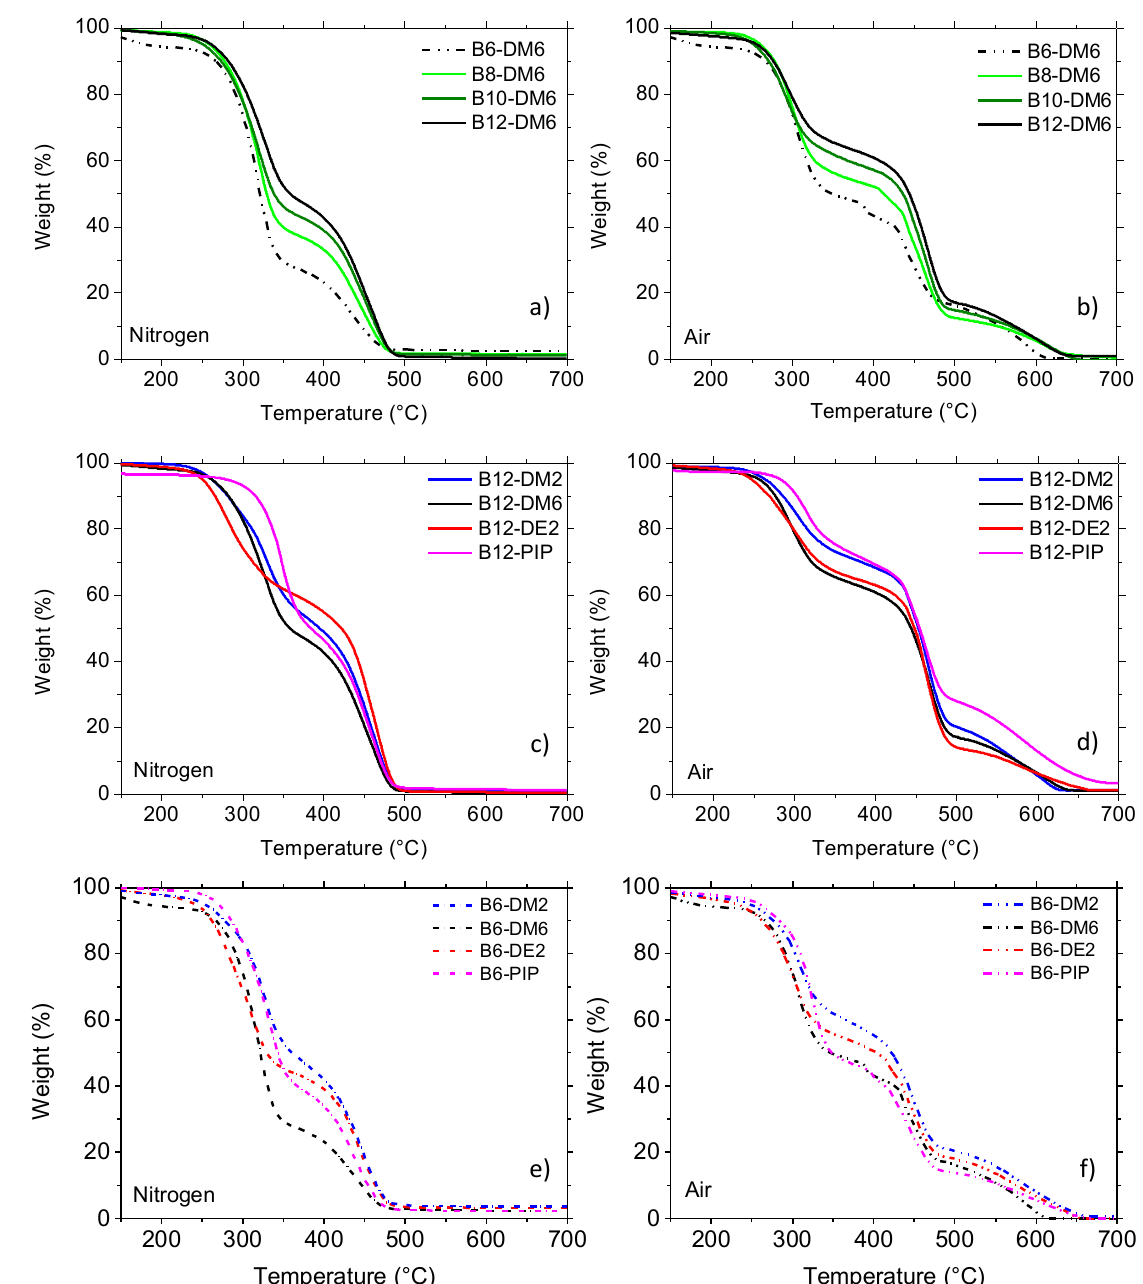
Figure 3. TGA thermograms of H-PAAs: panels ( a , c , e ) in nitrogen; panels ( b , d , f ) in air. Table 5. Thermal data collected by thermogravimetric analyses (TGA).